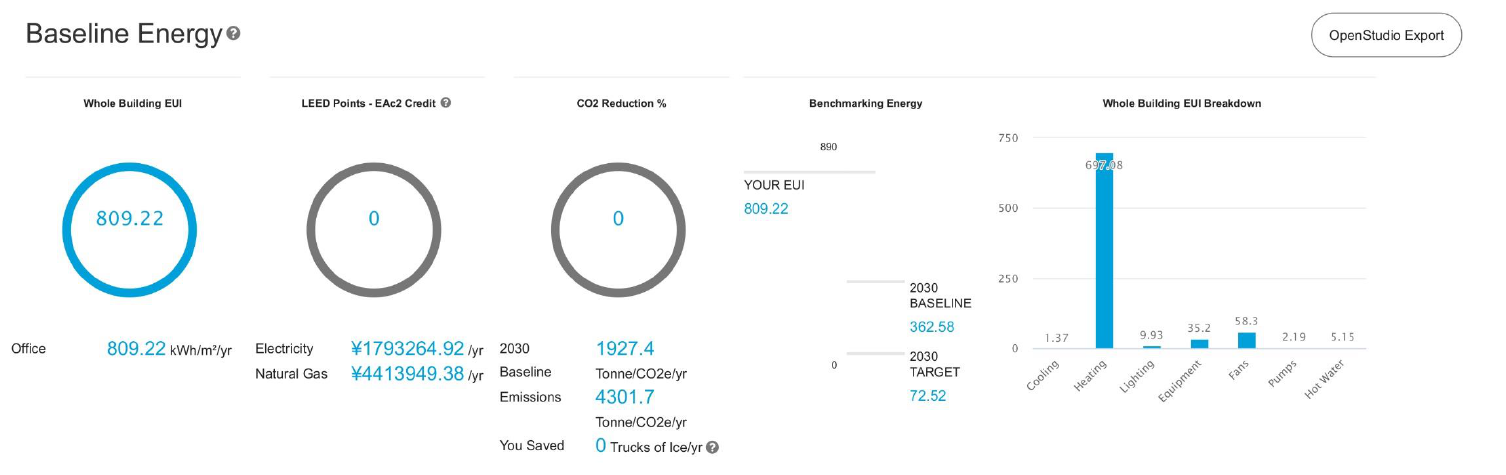
Figure A32. Zone 6-A Changchun, Jilin (post-COVID-19 78% scenario).